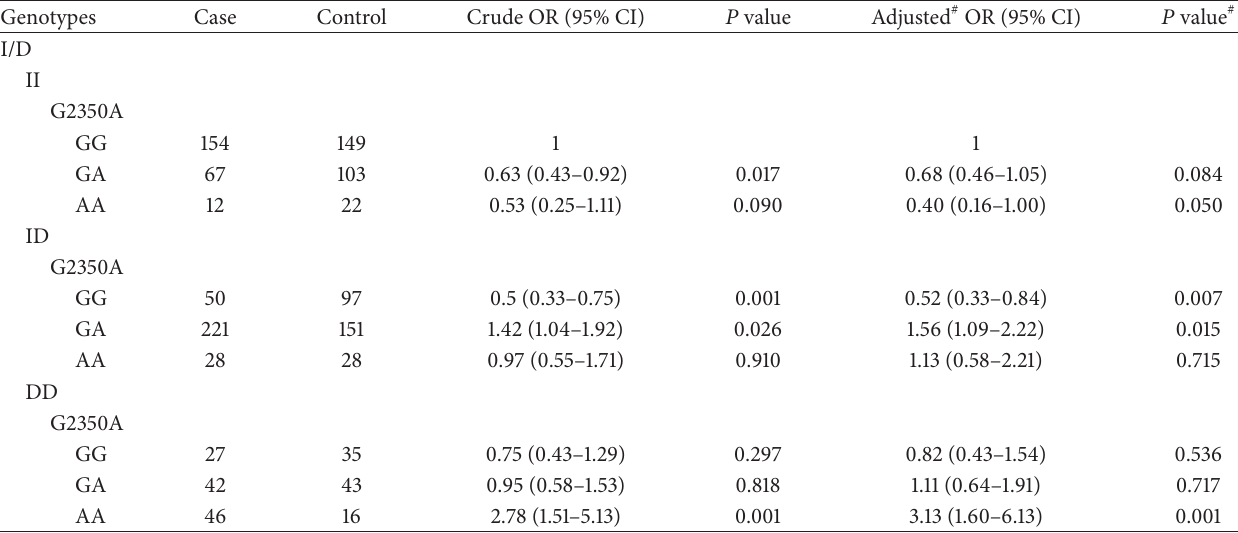
Table 5: Joint effect of ACE I/D and ACE G2350A from